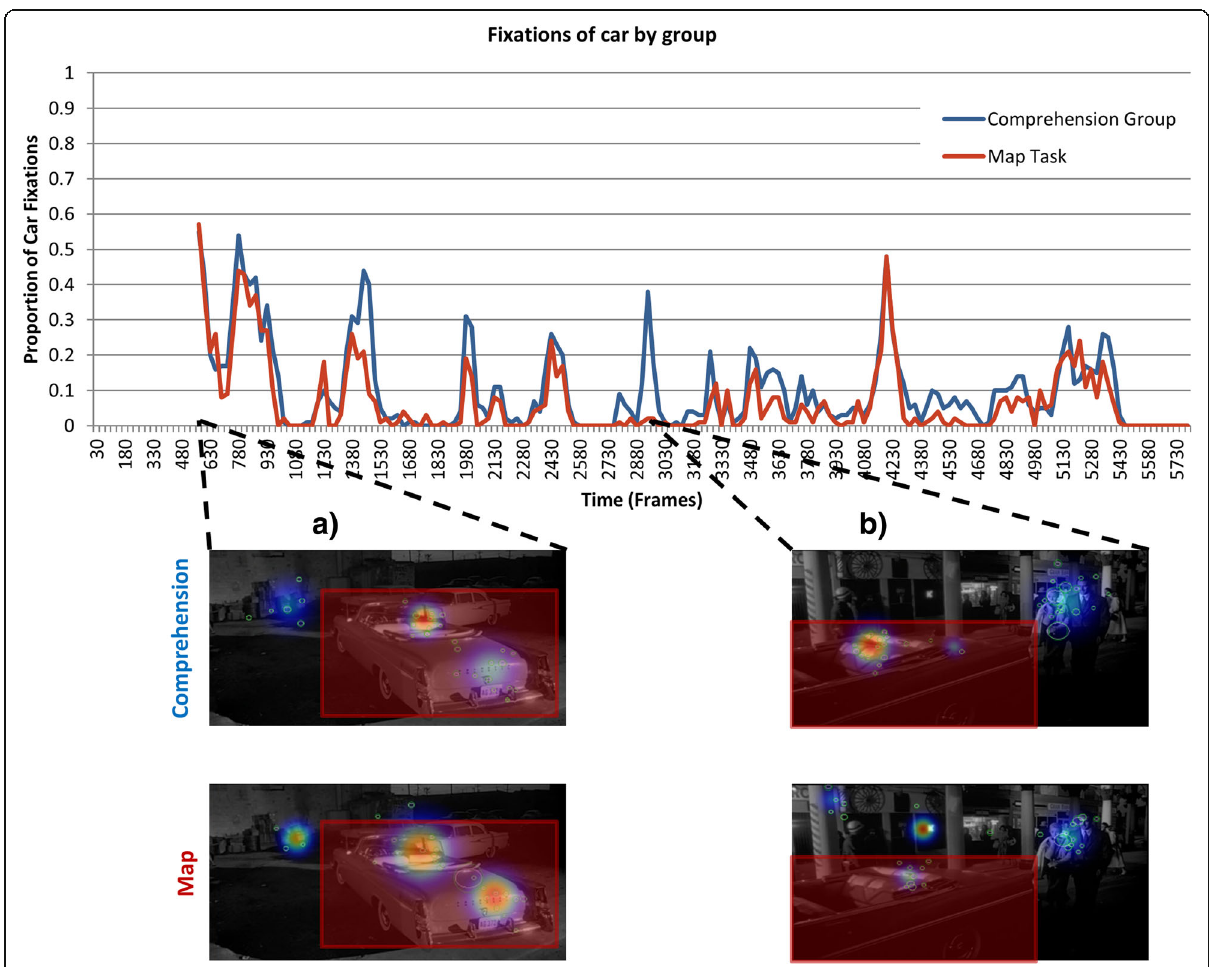
Fig. 7 Top : Proportion of participants fixating the car throughout the film clip (Comprehension group [ blue ], Map task group [ red ]). The higher the value, the more participants looked at the car. The car first appears in the clip at frame 541, which is in time bin 570. Bottom : Film stills show the region of interest for the frame, with fixation and heat maps superimposed. The stills indicate when both groups fixated the car at a similar rate ( a ) and when the car first reappears and was highly fixated by the Comprehension group, but not the Map task group, who looked at the storefronts ( b